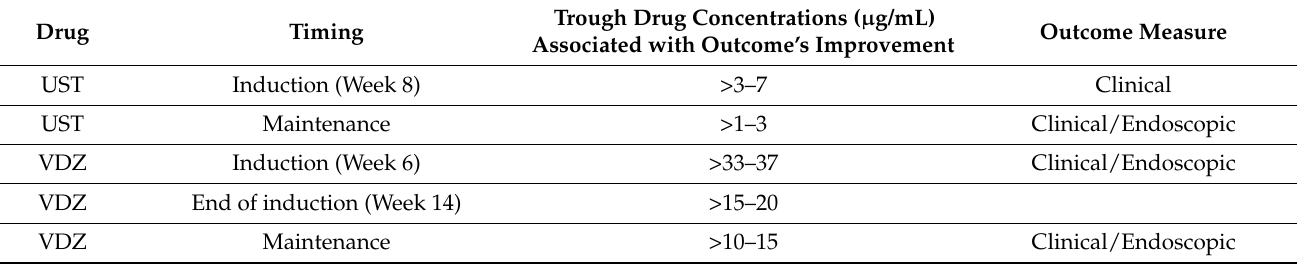
Table 2. Simplified summary of trough concentrations to target associated with outcome’s